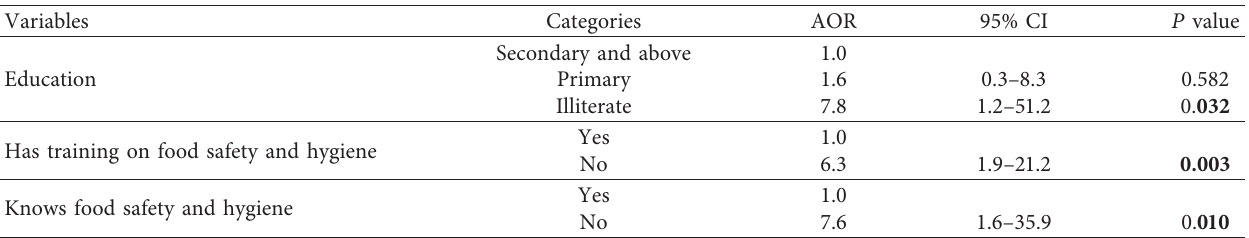
Table 9: Best-fitting model for predictors of Salmonella isolation in butchers and restaurants of Ambo and Holeta towns, central Ethiopia.